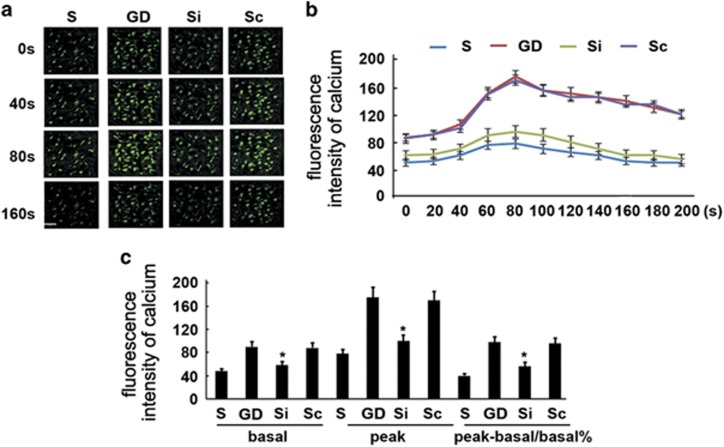
Calcium influx is increased in OPCs cultured in glucose-free medium. (a) Intracellular calcium concentration ([Ca2+]i) in OPCs was measured using the Ca2+ indicator Fluo-3 under laser confocal scanning microscopy. Fluo-3/AM fluorescence was markedly increased in OPCs after culture in glucose-free medium. Furthermore, RIPK3 inhibition via siRNA attenuated the glucose deprivation-induced calcium influx (scale bar=40 μm). (b) The mean fluorescence intensity curve for [Ca2+]i in each group with different treatments. Data are presented as means±S.E.M. from three independent experiments. N=6 for each group in each experiment. (c) Basal and peak fluorescence intensity for [Ca2+]i in each group. Data are presented as means±S.E.M. from three independent experiments. N=6 for each group in each experiment (P<0.05, comparing the siRNA group with the OGD/zVAD group). S, sham; GD, glucose deprivation; Si, RIPK3 siRNA; Sc, RIPK3 siRNA scramble